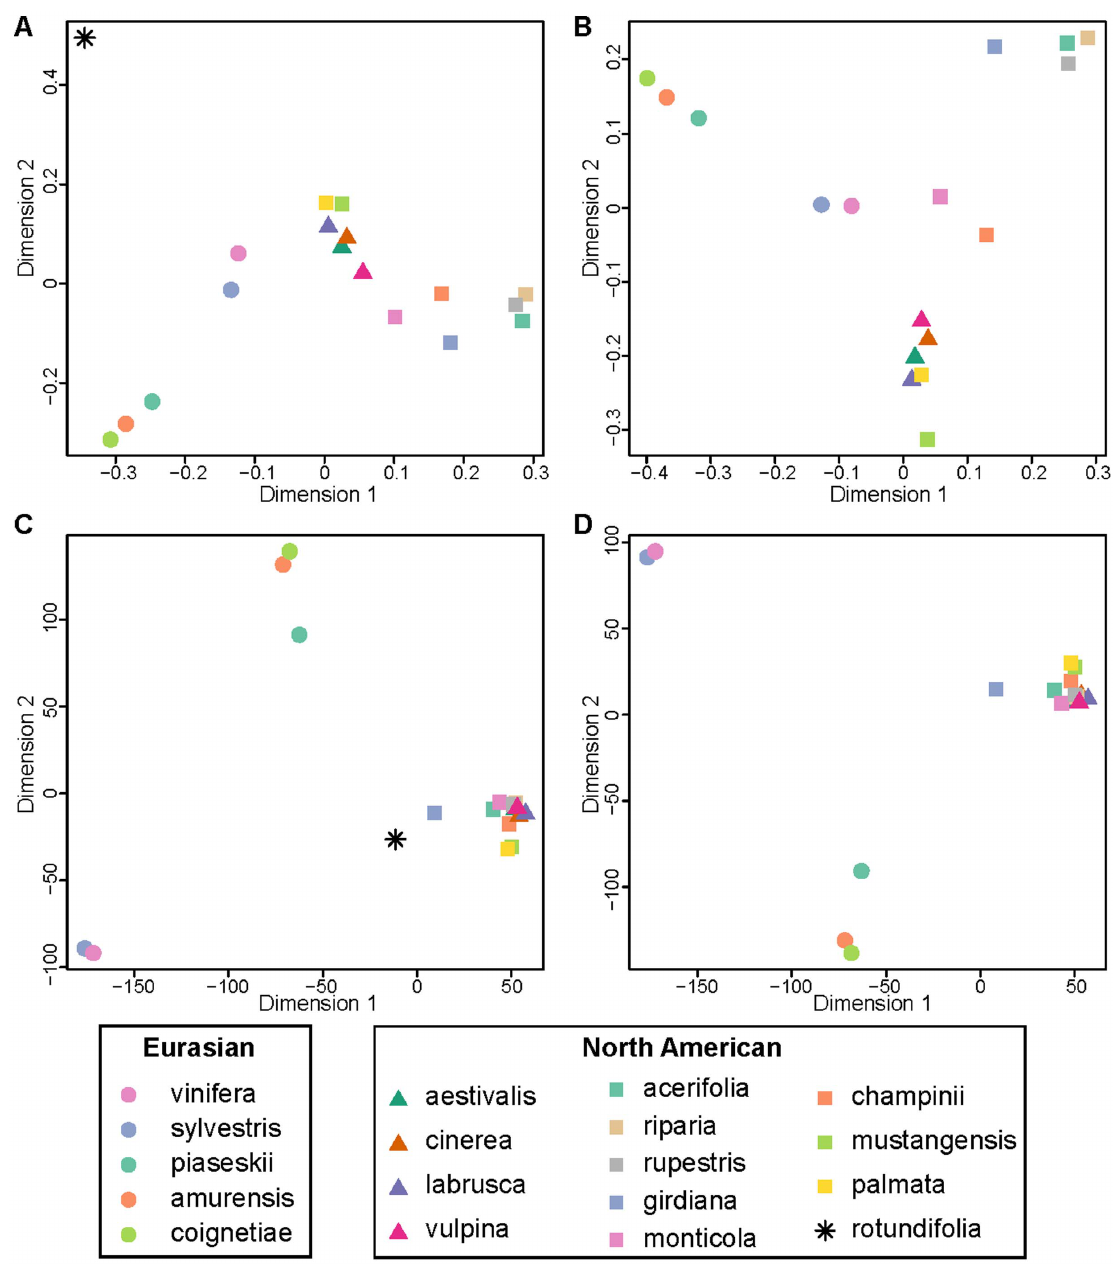
Figure 4. MDS plots of genetic distances among Vitis species using SNP genotype calls (A and B) and array hybridization intensities (C and D). A) MDS of F ST distances among all species calculated from genotype calls. B) Same as A) but without rotundifolia . C) MDS of genetic distances among all species based on intensity values. D) Same as C) but without rotundifolia